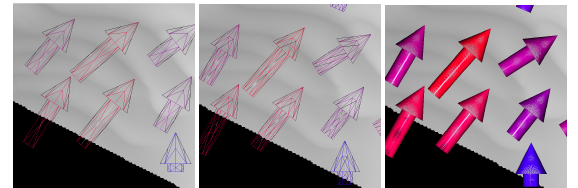
Figure 6: Glyph tessellation resolution: low (left), middle (mid- dle), and high (right).